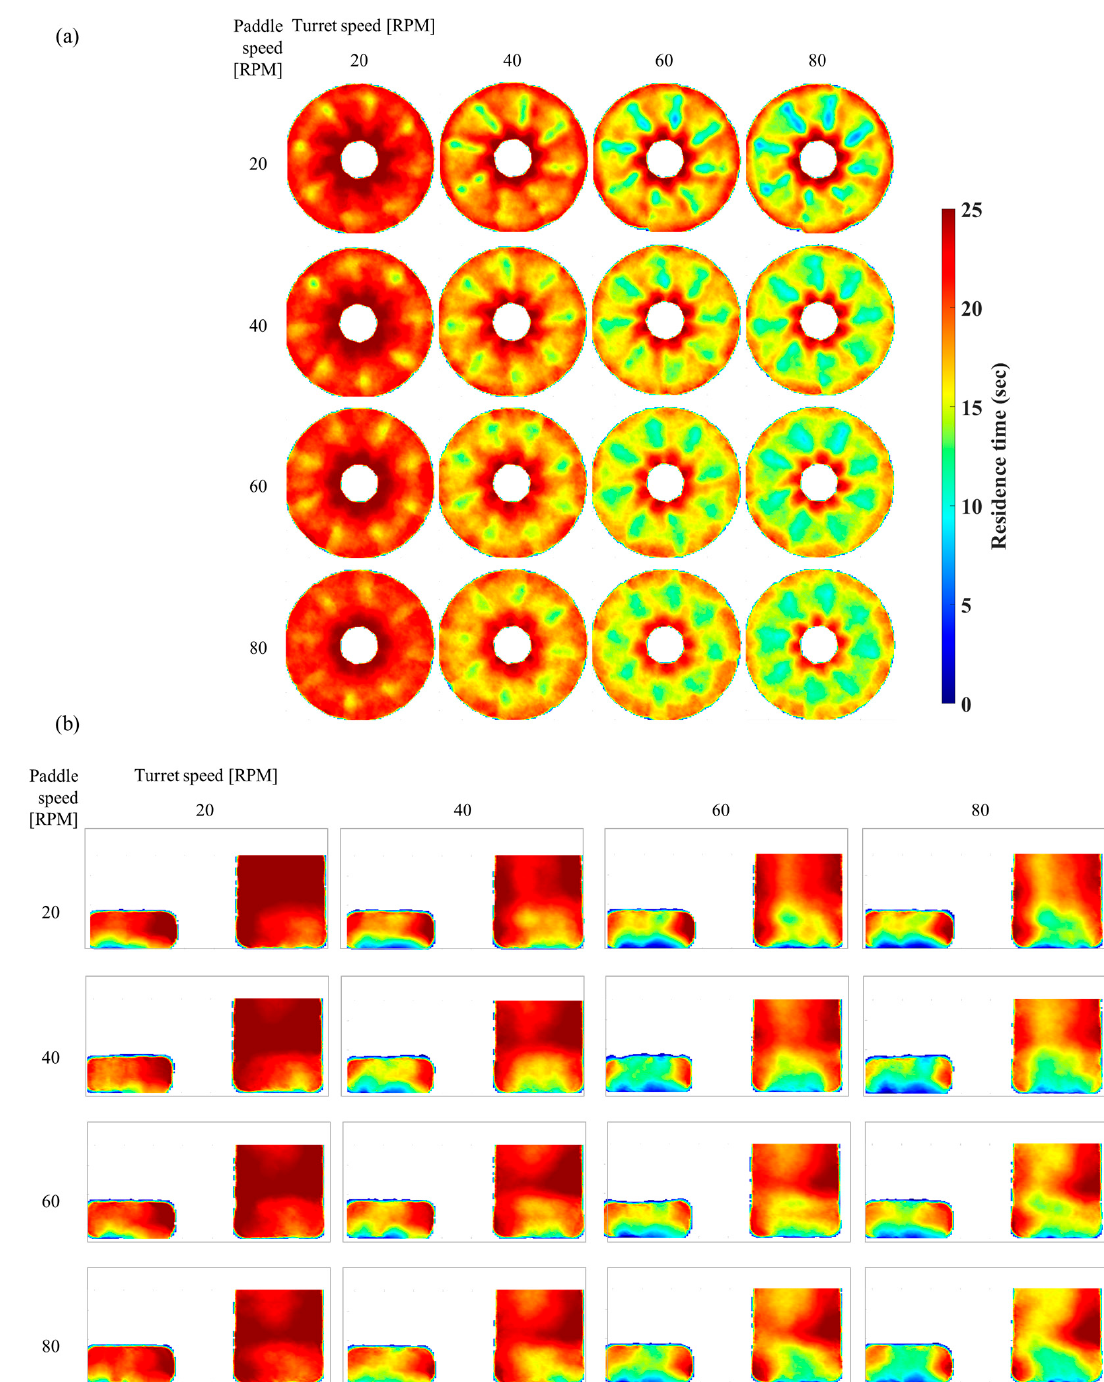
Figure 6. Continuous spatial images showing averaged residence time in the feed frame where each column corresponds to a different turret speed and each row corresponds to a different paddle speed: ( a ) top view plane at 16 different paddle and turret speeds; ( b ) side view plane at 16 different paddle and turret speeds (left: half of the chamber; right: half of the chamber and the hopper). Blue color indicates smaller residence times, and red color indicates larger residence times.